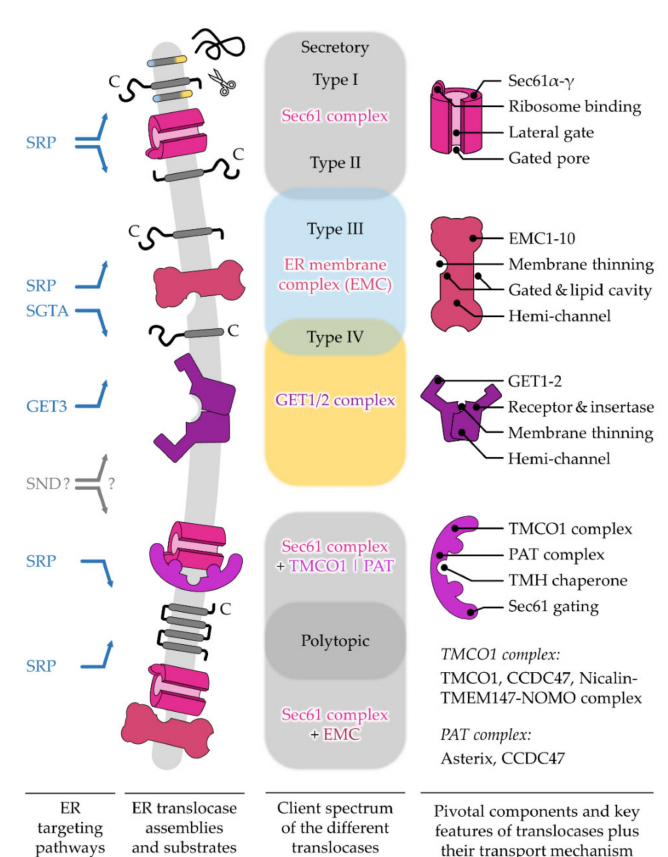
Figure 5. Features of protein translocation machines and their substrate spectrum. Depicted from the left to right are targeting pathways (blue), membrane-integrated protein translocation machines (pink, purple), their favored types of clients (boxes), and some key features for the central components of the protein translocation machines. Apart from GET1/2, the membrane-anchored receptor components for the targeting pathways are not shown. The scarcely characterized SND pathway (grey) as an alternative targeting route for a subset of GPI-anchored, tail-anchored, short secretory, and polytopic membrane proteins is indicated once. If SND delivers substrates either to a preferred ER translocase or a different one, or if its membrane-embedded component(s) might perform a dual function as receptor plus insertase similar to the GET1/2 complex remains to be seen. The auxiliary TMCO1 and PAT complexes are presented as one assembly. Of note, the PAT complex that was also described as a stand-alone intramembrane chaperone complex, is a heterodimer comprised of the indicated proteins CCDC47 and Asterix [251]. The TMCO1 containing translocon comprises the Sec61 channel and five accessory factors: TMCO1, CCDC47, and the Nicalin–TMEM147–NOMO complex [252]. For reasons of simplicity, we refer to those five accessory factors as “TMCO1 complex”. The PAT and TMCO1 complex share at least one subunit, CCDC47. Further details of the TMCO1–PAT–Sec61 assembly and how they might act in concert to form an operational protein translocase can be found in the text. Signal peptides and transmembrane helices are integrated into the ER membrane and classified and colored according to Figures 1 and 2. The cleavage of signal peptides for secretory and type I membrane proteins is indicated (scissors and cleaved signal peptides are shown) as is the C-terminus (C) for each type of membrane protein. The spectra of substrates preferentially handled by assemblies that entail the Sec61 complexes are represented by grey boxes. Substrates handled by the ER membrane complex (EMC) and the GET1/2 complex are highlighted by light blue and yellow boxes, respectively. Overlapping boxes depict overlaps in the substrate range. CCDC47, coiled-coil domain containing protein 47; NOMO, nodal modulator protein; TMCO1, transmembrane and coiled-coil domain-containing protein 1; TMEM147, transmembrane protein